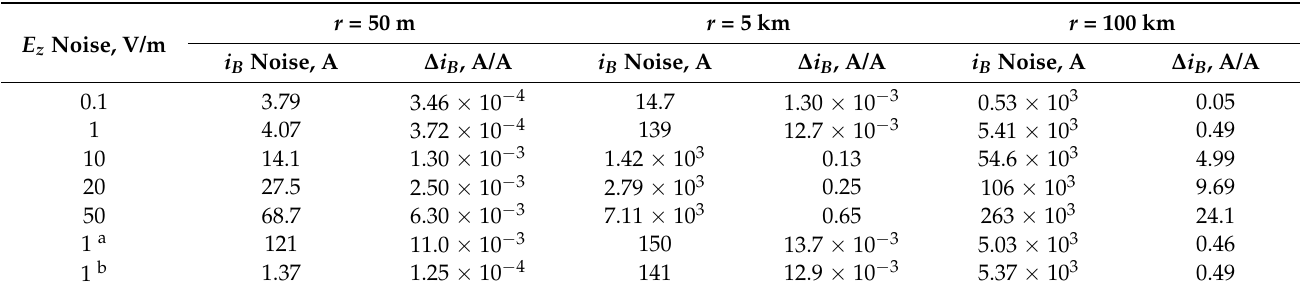
Table 1. Lightning channel base current noise levels computed from noised electric field waveforms for different distances from the lightning strike